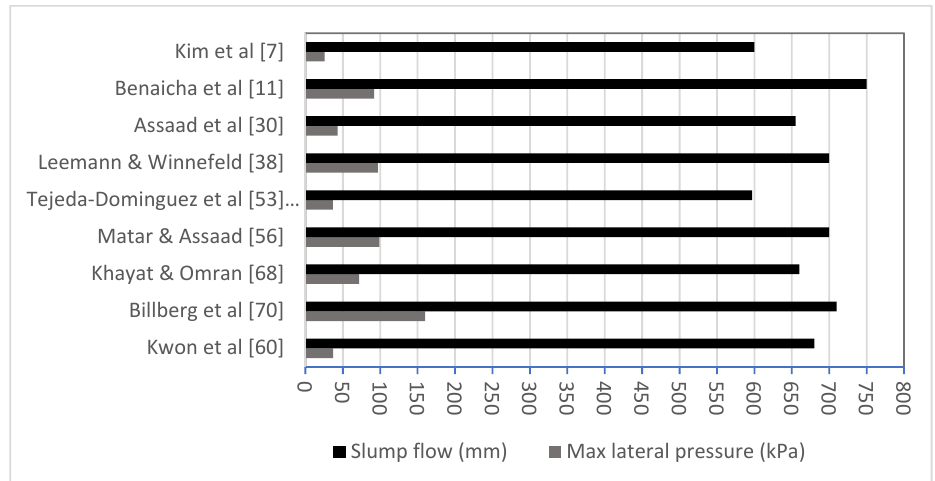
Figure 1. Correlation between slump flow and formwork pressure for different mix designs.